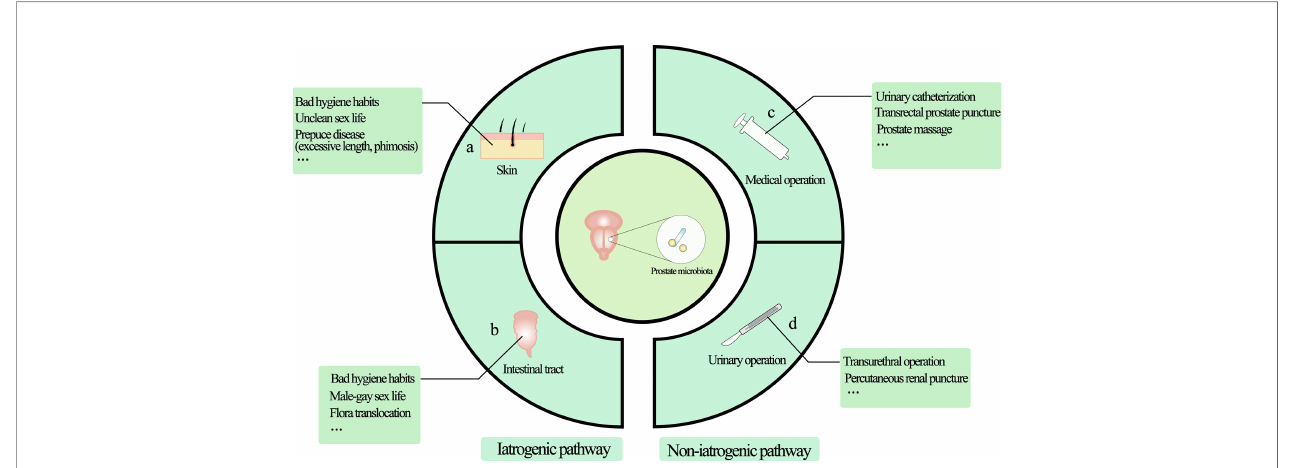
FIGURE 1 | The main source of prostate microorganisms. The source of prostate microorganisms is mainly from the external environment of microorganisms through the urethra into the urinary system and implanted in the prostate due to various factors, mainly divided into iatrogenic pathway and non-iatrogenic pathway. (A) Skin-derived microbial infections are mainly microorganisms located in the vulva or other parts through the urethral ori fi ce with the help of bad/unclean living habits (including sexual life), such as Propionibacterium acne and staphylococci. (B) Intestinal-derived bacteria such as Escherichia coli are the most common bacteria in UTIs, so they are also the most common bacteria in the prostate, mainly from retrograde infections. (C) Non-standard medical procedures may bring microorganisms from the external environment into the urethra through instrument consumables to cause microbial colonization. (D) Patients who need urinary tract surgery often have microorganisms in their urinary system, and microorganisms can be transferred with the help of surgical procedures. Non-standard surgical procedures can also bring microbes from the external environment into the urinary tract